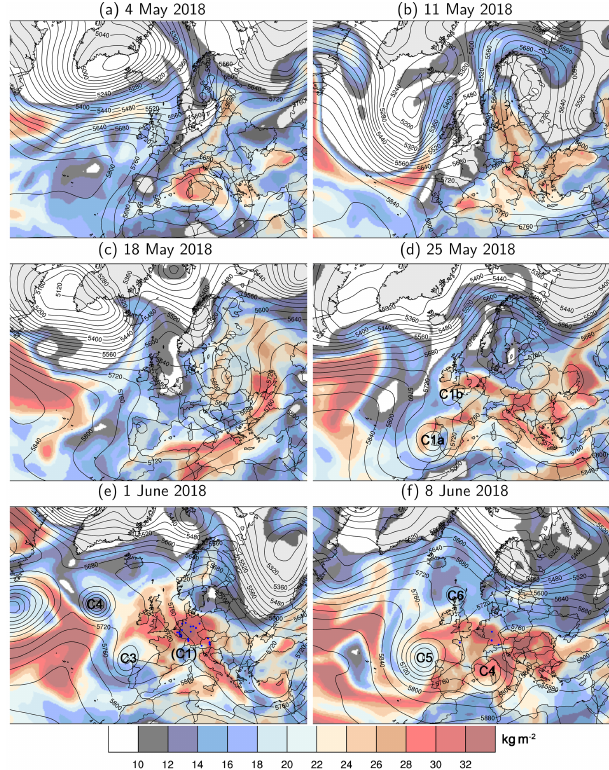
Figure 5. The 500hPa geopotential height (contours every 40gpm) and vertically integrated water vapour (IWV, shaded in kgm − 2 ) for selected days at 00:00UTC during the extended study period: (a) 4 May, (b) 11 May, (c) 18 May, (d) 25 May, (e) 1 June, and (f) 8 June (ERA-Interim). Several cut-off lows during the study pe- riod mentioned in the text are indicated with numbers (C1–C6). Small blue dots in panels (e) and (f) mark the ESWD reports of heavy rain from Fig. 2. Note that there are no ESWD reports for panels (a) – (d)